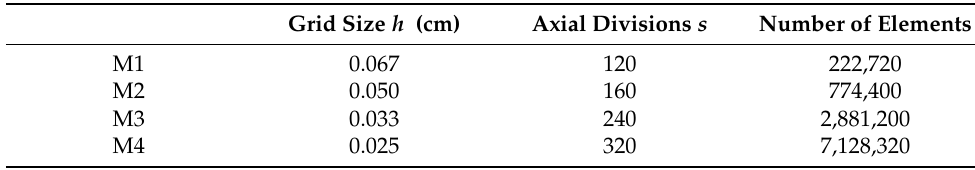
Table 8. Mesh data for 3D rising bubble C1 case mesh sensitivity